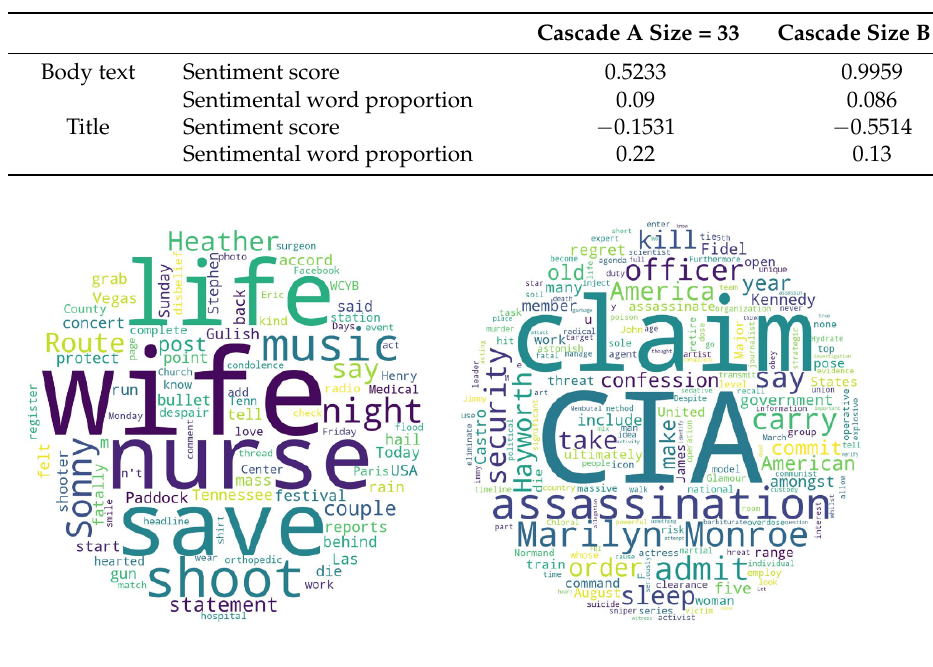
Figure 14. Visualization of high frequency terms in news having different cascade